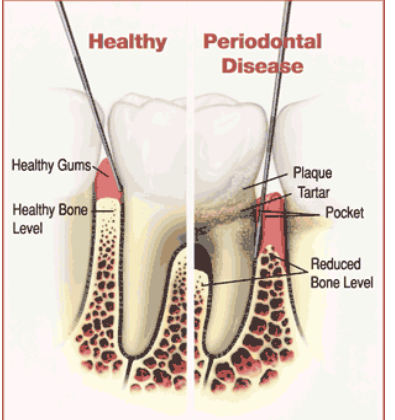
Figure 1. Representation of the structure of a healthy tooth and how it is typically affected by periodontal disease (picture source: American Academy of Periodontology;